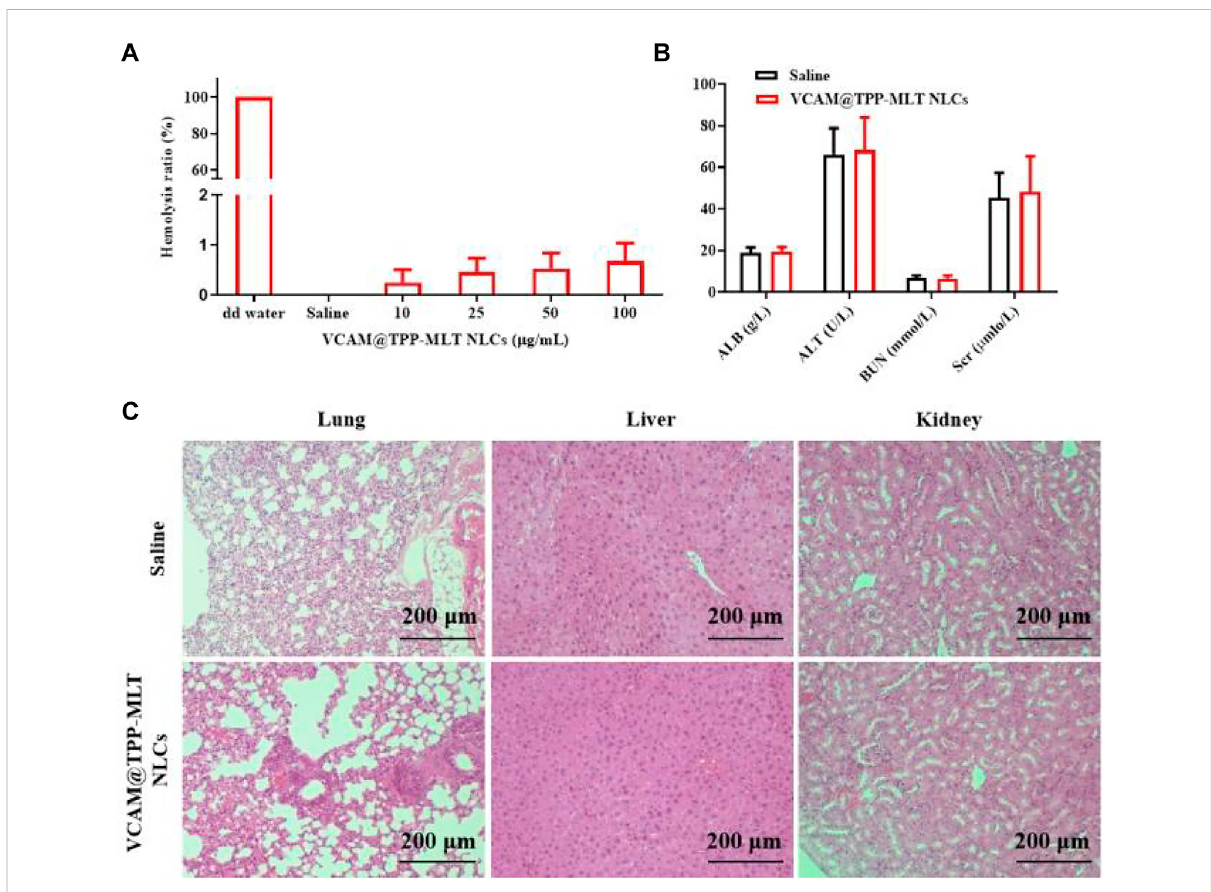
FIGURE 3 Safety and biocompatibility of VCAM@TPP-MLT NLCs. (A) Hemolysis ratios of VCAM@TPP-MLT NLCs. (B) The in fl uences of VCAM@TPP-MLT NLCs on the liver and renal functions. The data represent the mean ± SD ( n = 6). (C) Representative H&E staining images of liver, lung and kidney in mice treated with saline or VCAM@TPP-MLT